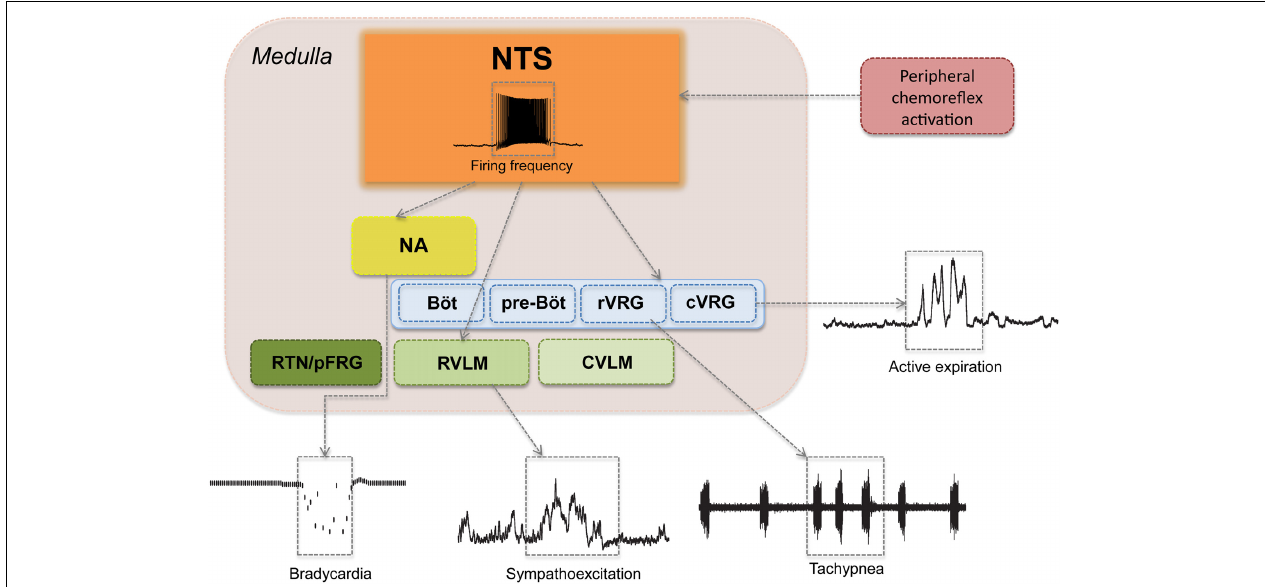
FIGURE 4 | Major pontine and medullary regions involved in the cardiovascular and respiratory responses to peripheral chemoreflex activation. Aortic and carotid bodies and supra-medullary pathways are not shown. Observe that peripheral chemoreflex activation recruits several brainstem nuclei in series and in parallel in order to produce a patterned and integrated cardiorespiratory response to hypoxia, which is characterized by (1) bradycardia, represented here as a decrease in instantaneous heart rate; (2) sympathoexcitation, demonstrated here as increases in the amplitude of